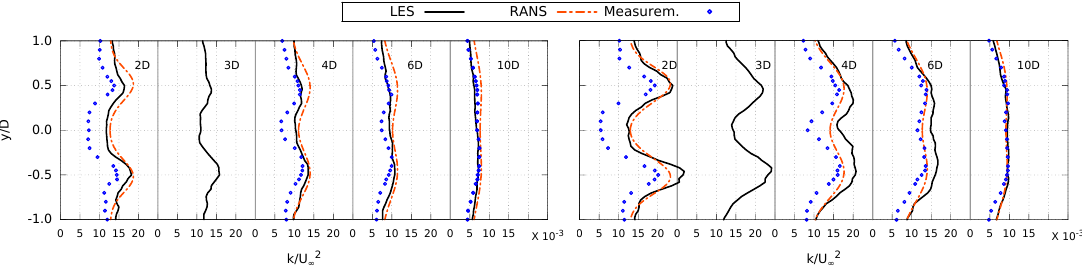
-1.0 Figure 8. Vertical profiles of k behind the disk C T = 0.45 ( left ) and C T = 0.71 ( right ), Ti12 case.